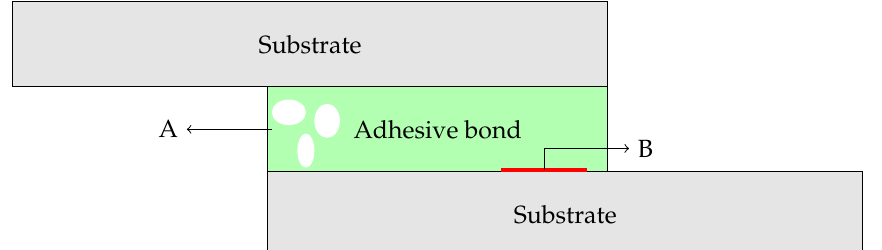
Figure 1. Representation of common defects in an SLJ, with “A” illustrating voids in the adhesive and “B” indicating weak adhesion.